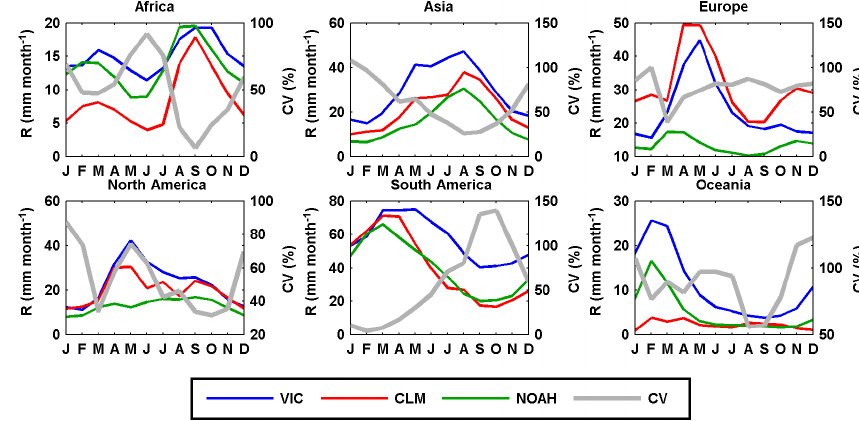
Figure 6. Seasonal cycles of runoff from different products over the six continents for 1984–2010.